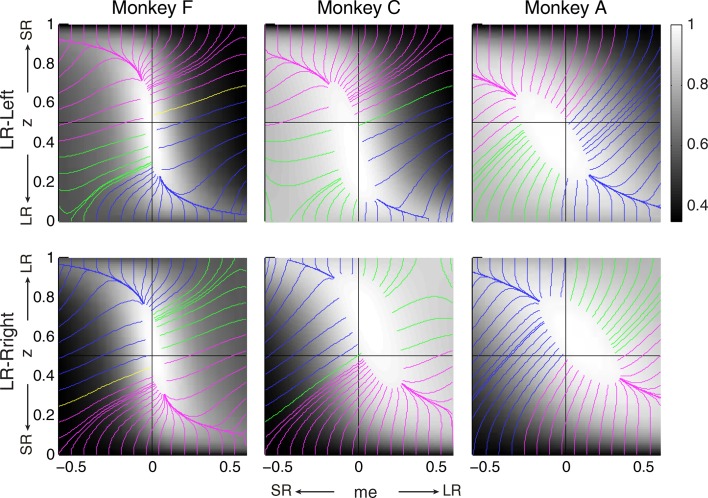
RR gradient trajectories color-coded by the end points of the me/z patterns.Same format as Figure 7 but using gradients based on RR instead of RTrial.